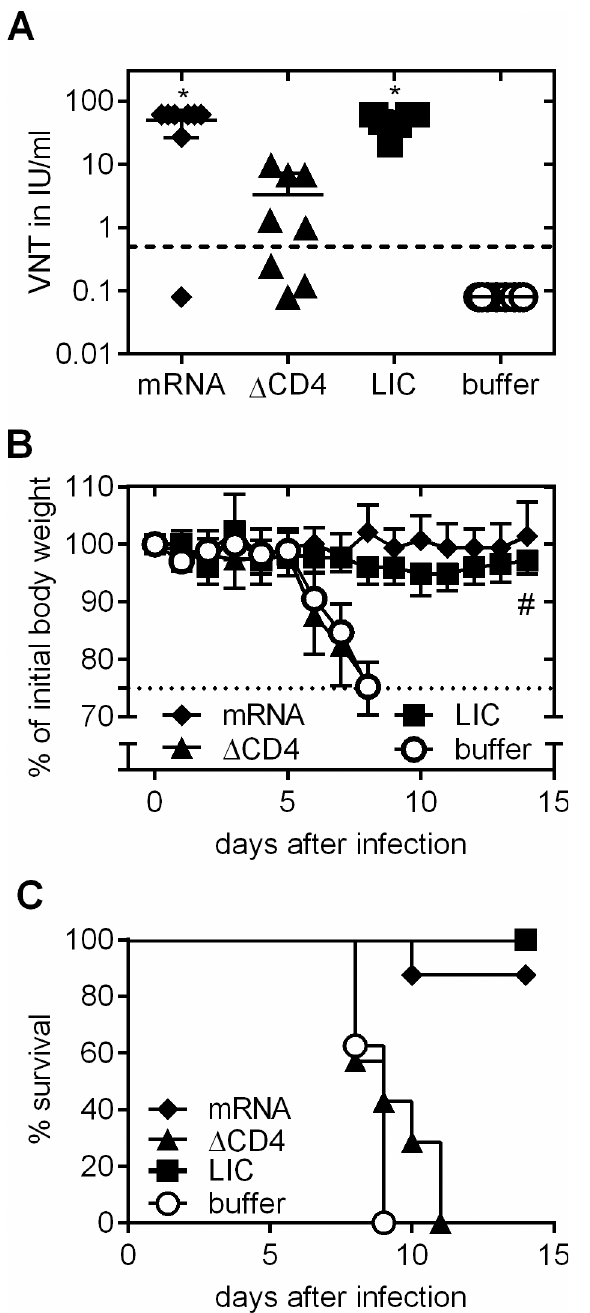
Fig 5. CD4+ T cell depletion during immunization phase followed by challenge infection. Female BALB/c mice were vaccinated with RABV-G mRNA, Rabipur (LIC) or injection buffer alone on days 0 and 21. The CD4+ T cell population was specifically depleted in one mRNA-receiving group by injection of anti-CD4 antibody on days -1, 1, 20 and 22. (A) Evaluation of rabies virus neutralizing antibodies in sera of control, vaccinated or vaccinated and CD4-depleted mice 4 weeks after the second immunization using the FAVN test (n = 8/group). Mean and SD is presented. Significance between the buffer control group and immunized groups was calculated using the one-way ANOVA Tukey ’ s multiple comparison test ( * p < 0.05). (B , C) Mice were challenged with a lethal dose of rabies virus and (B) body weight was monitored daily. A loss of 25% of initial body weight was defined as humane endpoint. Mean and SD is presented. (C) Survival of challenged mice. # note: the sacrificed mouse in the RABV-G mRNA (black diamond) group was excluded from the body weight analysis to demonstrate the healthy state of the remaining animals. This mouse was also negative for rabies specific antibodies (see Fig 5A).